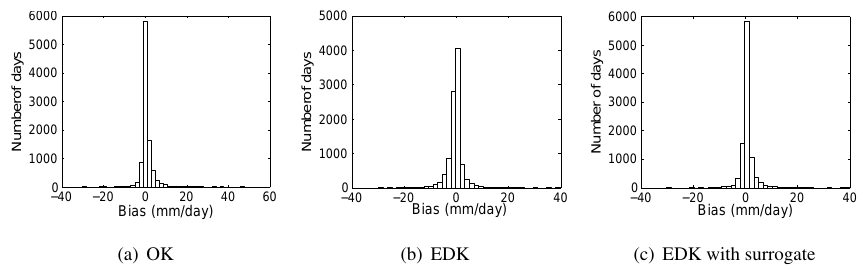
Fig. 16. Histogram of bias for different interpolation procedures at the station Zastler